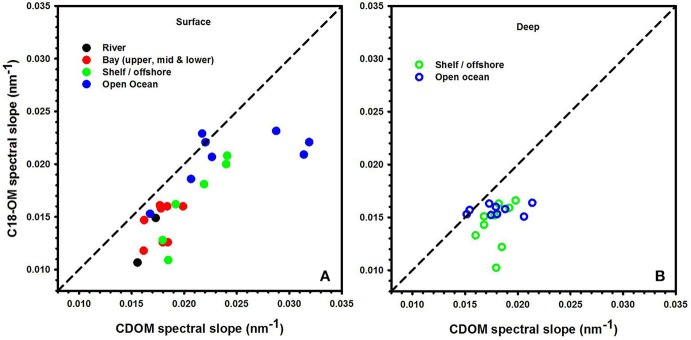
Spectral slope values acquired for CDOM and C18-OM for river, bay, shelf, and open ocean waters from the MAB and EAO. Solid symbols represent surface samples (A). Open symbols represent depths below the surface (B). 1:1 line is also shown.